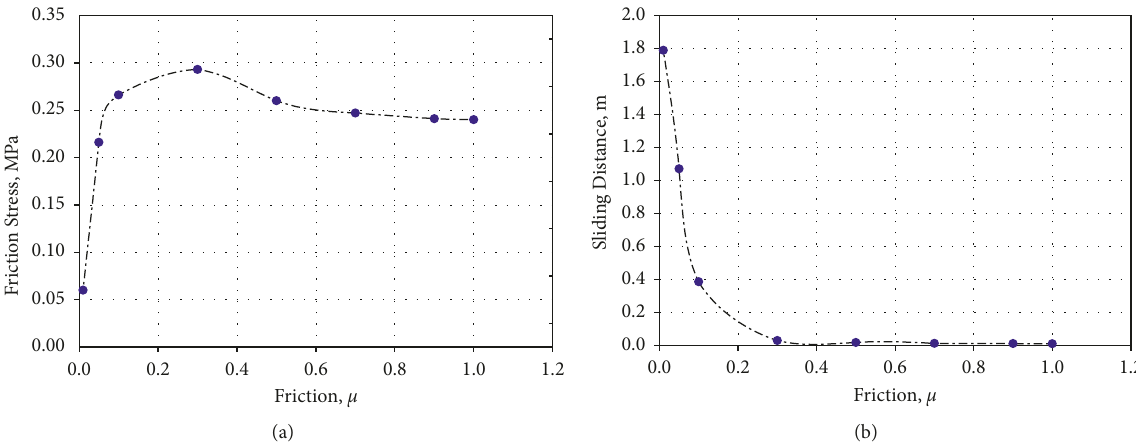
Figure 18: Effect of interface coefficient of friction between old and new section: (a) max shear frictional stress and (b) maximum sliding distance at interface layer.